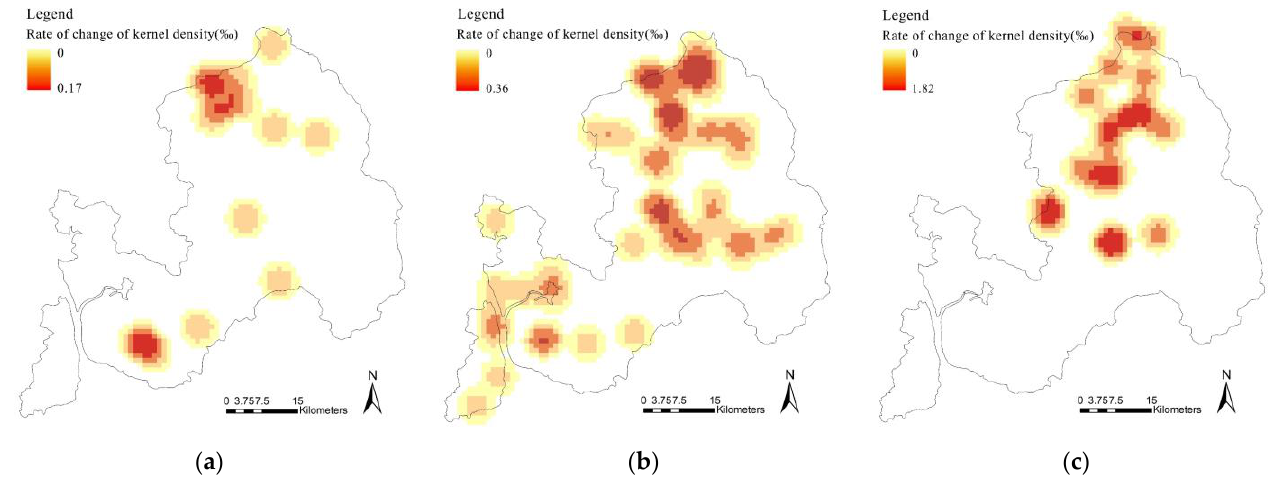
Figure 7. The change rate of the market town kernel density. ( a ) Song Dynasty to the years of Jiajing in the Ming Dynasty; ( b ) the years of Jiajing in the Ming Dynasty to the late Qing Dynasty in 1909; ( c ) 1909 in the late Qing Dynasty to 1931 in the Min-Guo Period.